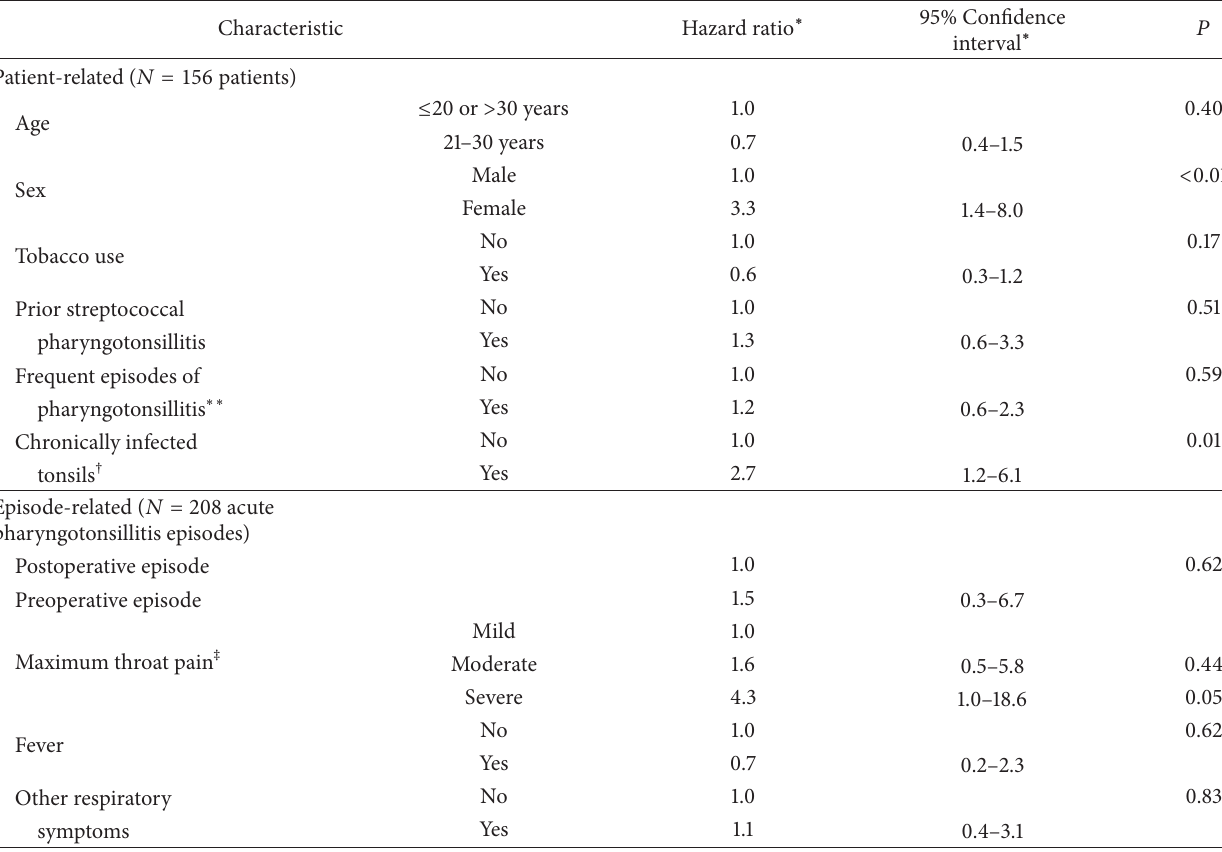
Table 2: Association between various patient- and episode-related factors and having a medical consultation during an episode of acute pharyngotonsillitis in a material based on two randomised trials in Finland [2, 3]. Characteristic Hazard ratio